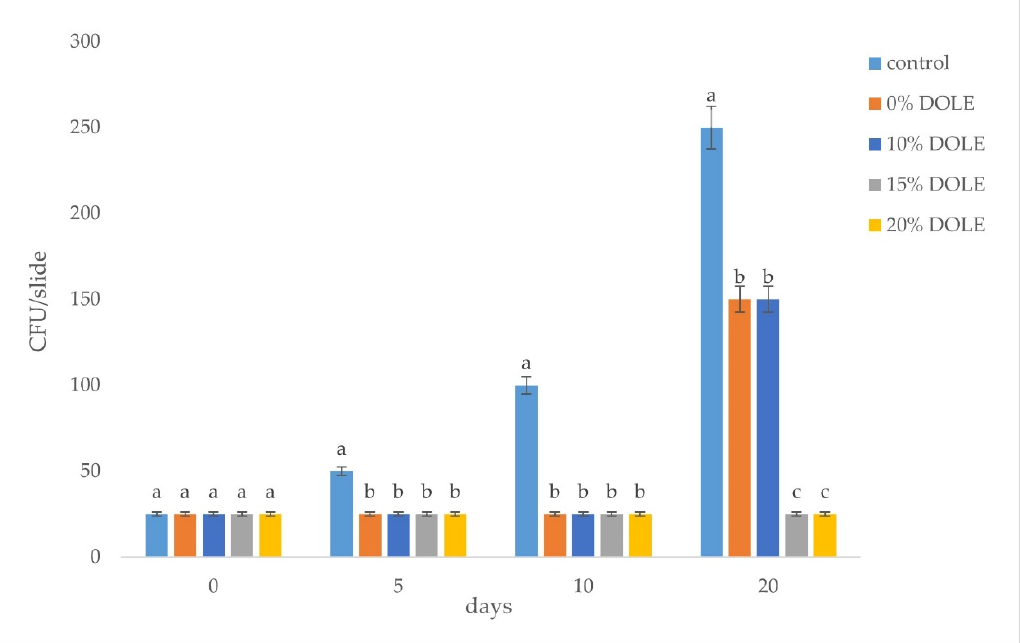
Figure 7. CFU ( Enterobacteriaceae ) in meat samples covered with DOLE-containing films. Controls represent samples covered with baking paper. Different small letters (a–c) indicate significant differences among the values reported in each bar ( p < 0.05).